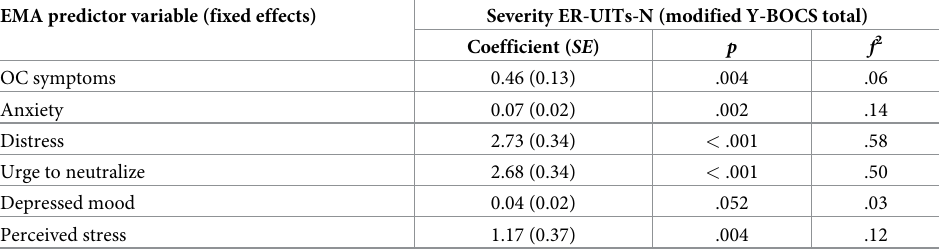
Table 3. Associations between the EMA severity of ER-UITs-N (outcome) and other EMA variables (predictors). EMA predictor variable (fixed